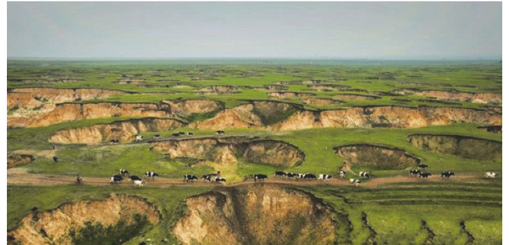
Figure 2: The huge and numerous collapse pits distributed in the Hulun Buir, where the vegetation, environment, and ecological system were damaged